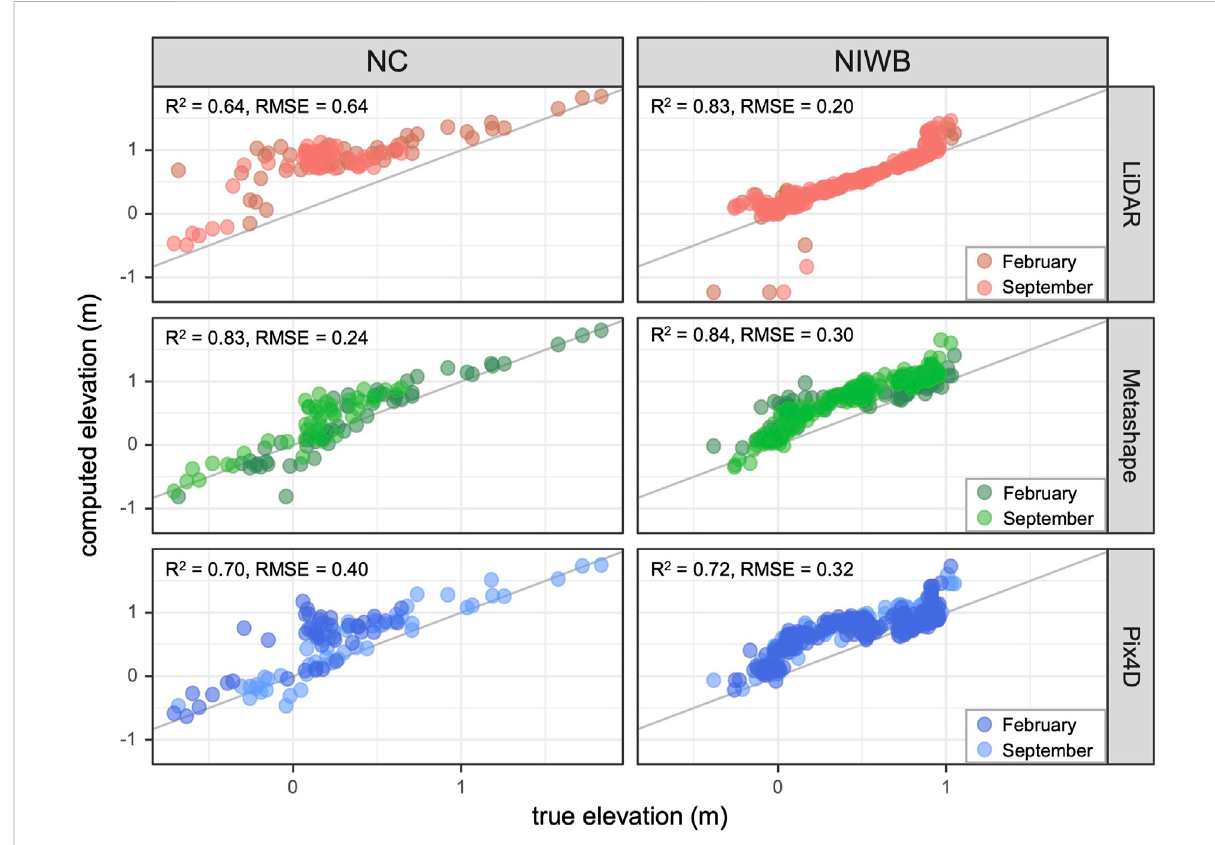
FIGURE 4 LiDARdatasetsdemonstratehigherverticalerrorthanSfM-derivedmodelsatNCbutlowererroratNIWB.DTMverticalerroriscalculatedasthe difference between model elevation and GNSS-recorded elevations and represented for each site-method pair as the Root Mean Square Error (RMSE).